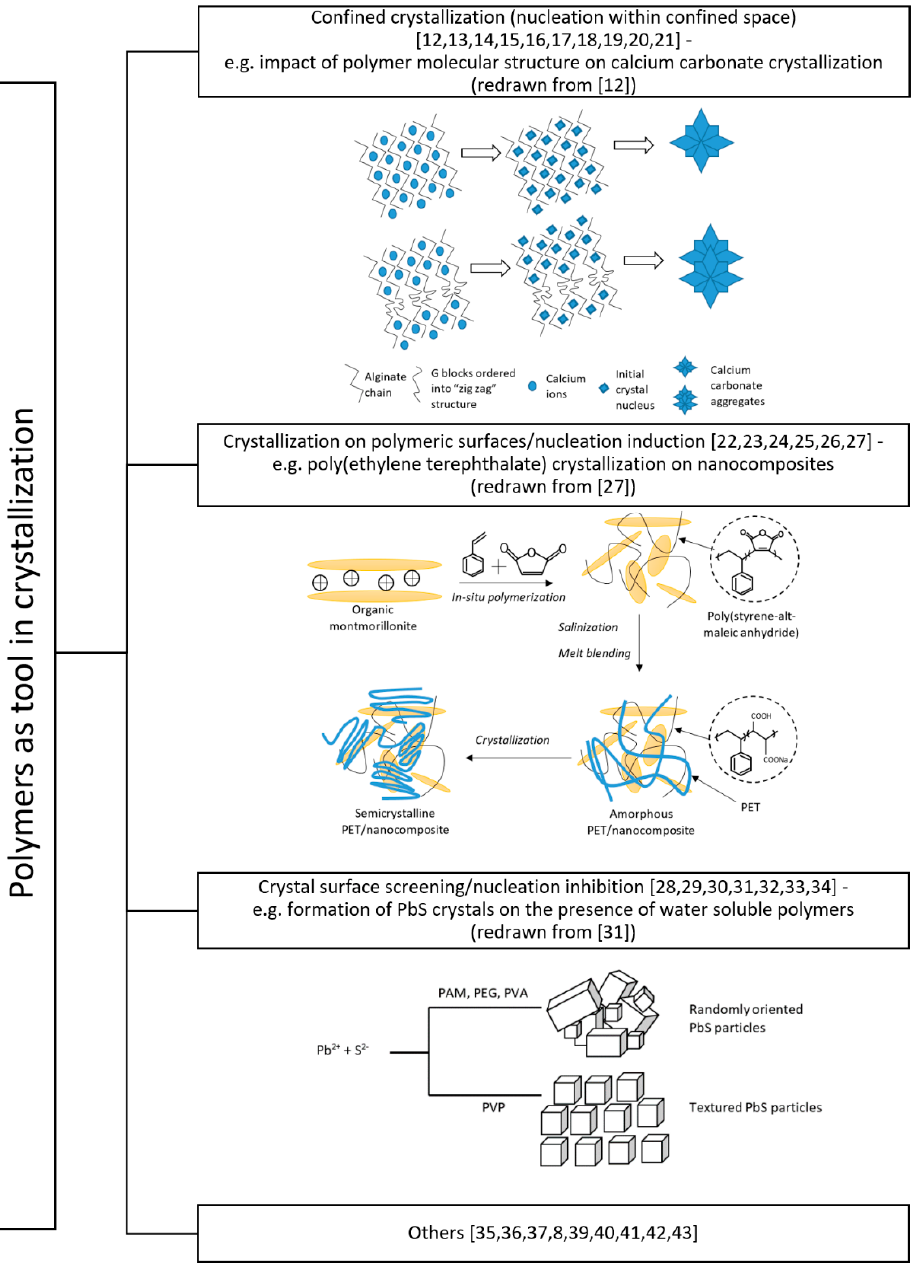
Figure 1. The classification of polymers’ usage as a tool in the crystallization process. Simultaneously, knowledge of the relationship between crystallization and phase sepa- ration is important to optimize solution processing performance of polymer blends.